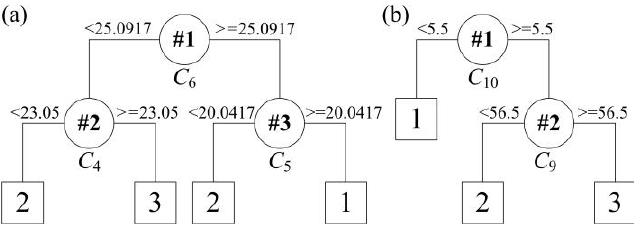
Figure 5. Tree structure for rule extraction on the dataset of rule R 1 ( a ) and R 2 ( b ).